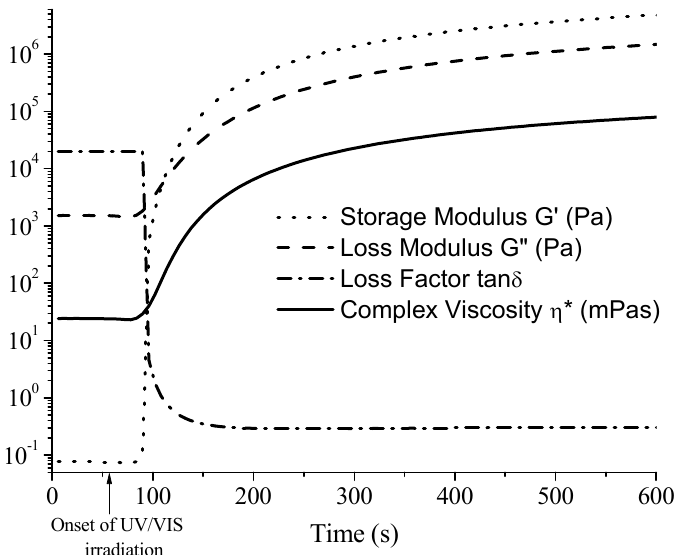
Figure 2. The dependencies of storage modulus G’, loss modulus G”, loss factor tanδ and complex viscosity η* of AESO on irradiation time.